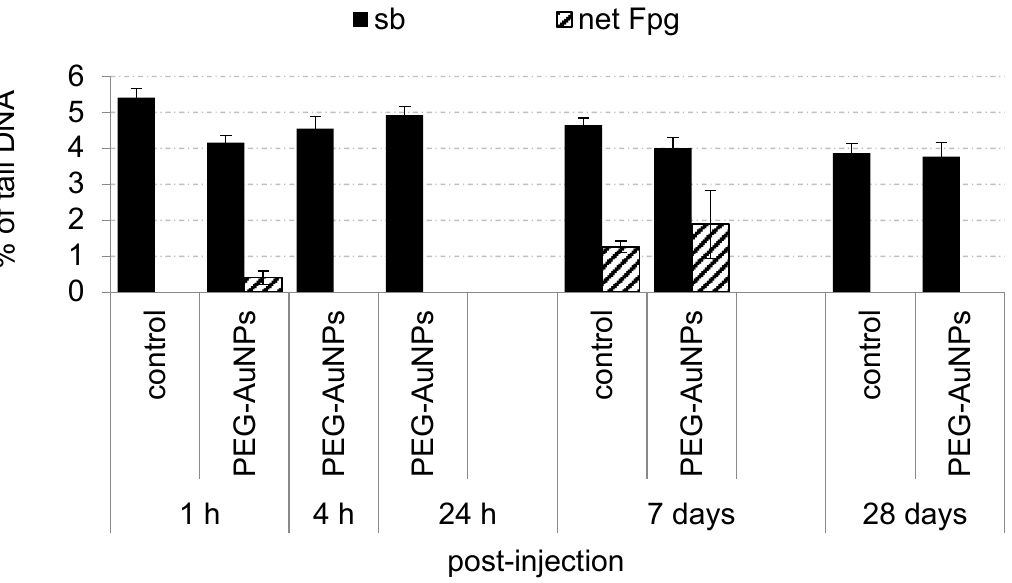
Figure 4. Genotoxic effects and oxidative damage to DNA induced by PEG-AuNPs in the blood mononuclear cells. Data are presented as mean ± standard error of the mean (SEM).